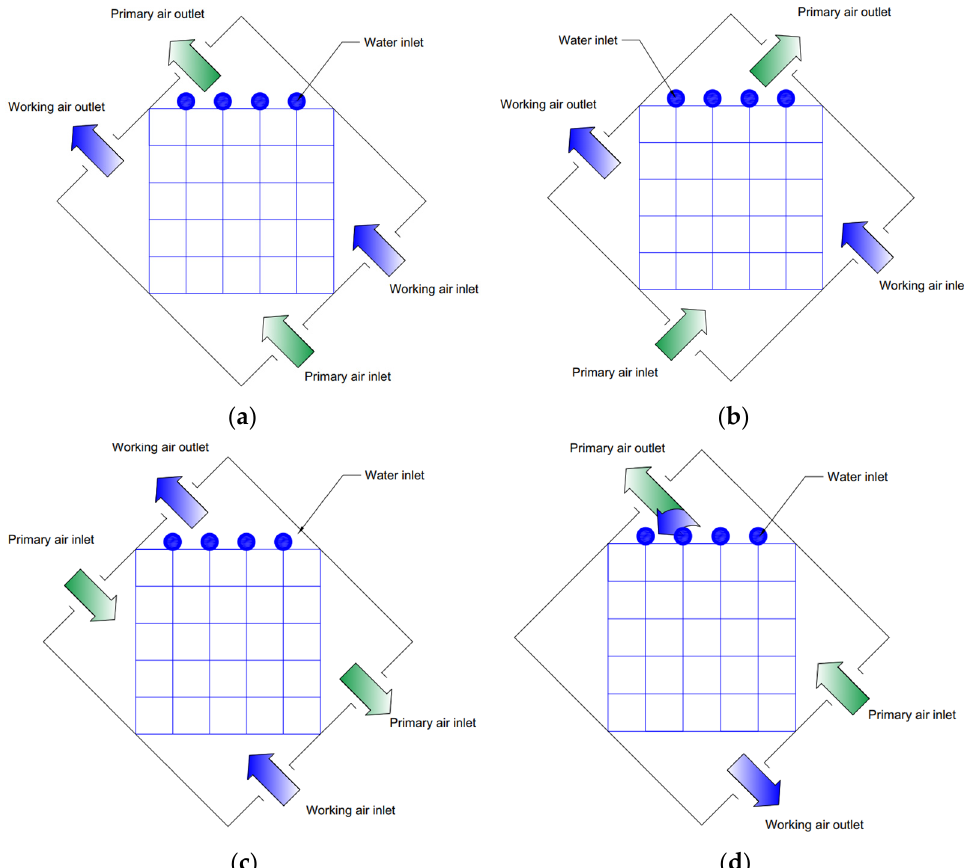
Figure 7. Visualization of a few indirect evaporative solutions: ( a ) parallel flow, ( b ) counter-flow IEC, ( c ) cross-flow IEC, ( d ) regenerative IEC [41].